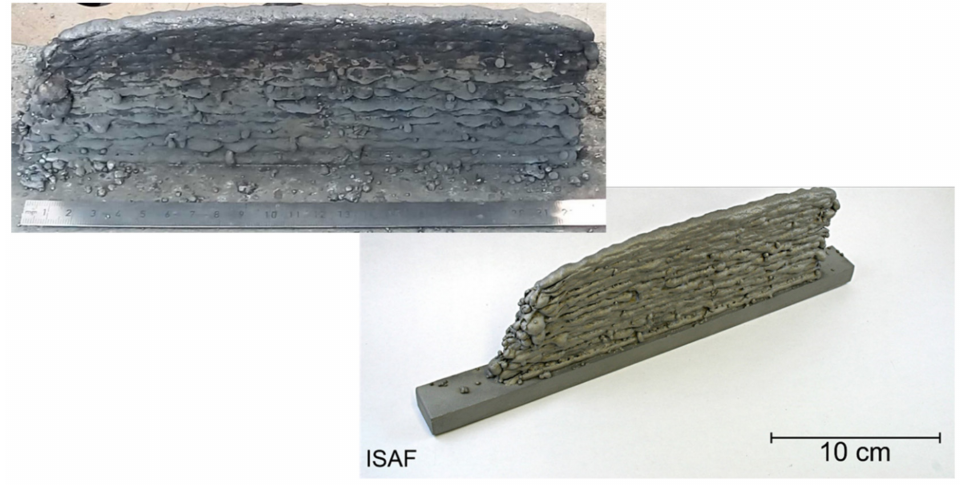
Figure 5. Additive manufactured wall-like structure after deposition ( left ) and after sand blasting ( right ).